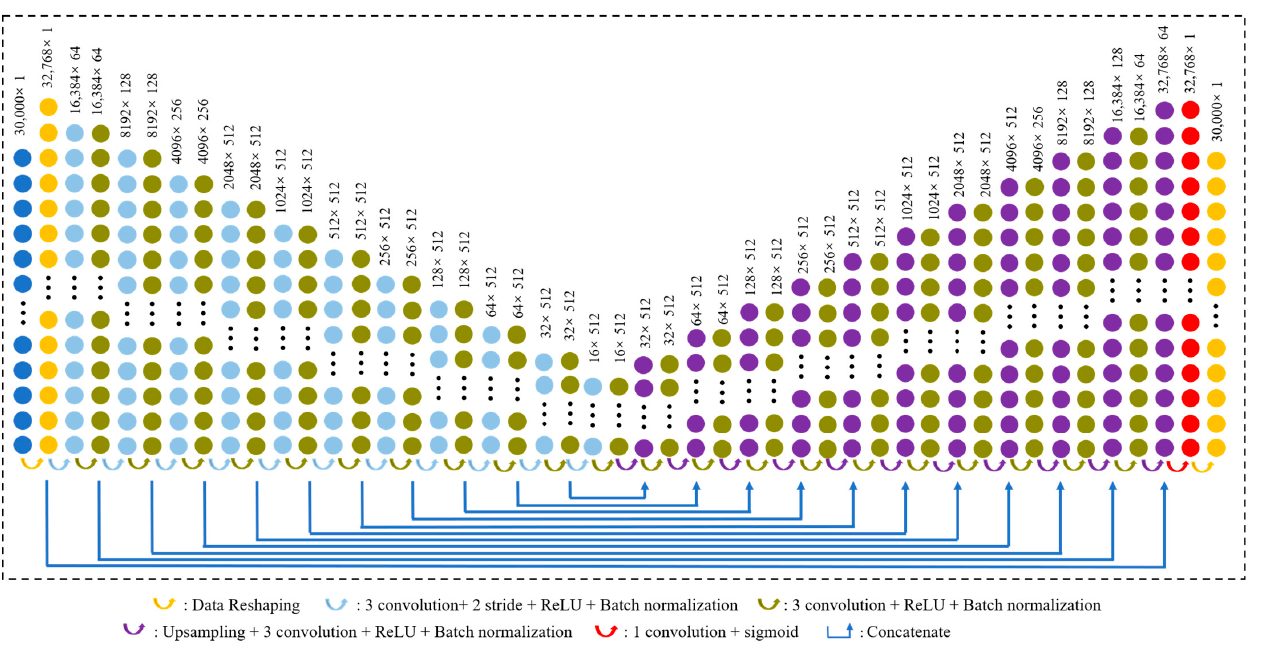
Figure 7. Structure diagram of denoising and detection models for model efficiency comparison. The circles of different colors represent the neural network layer. The arrows represent operations performed between two adjacent layers. The dimensions of each layer are marked as ‘feature × fil- ters’.